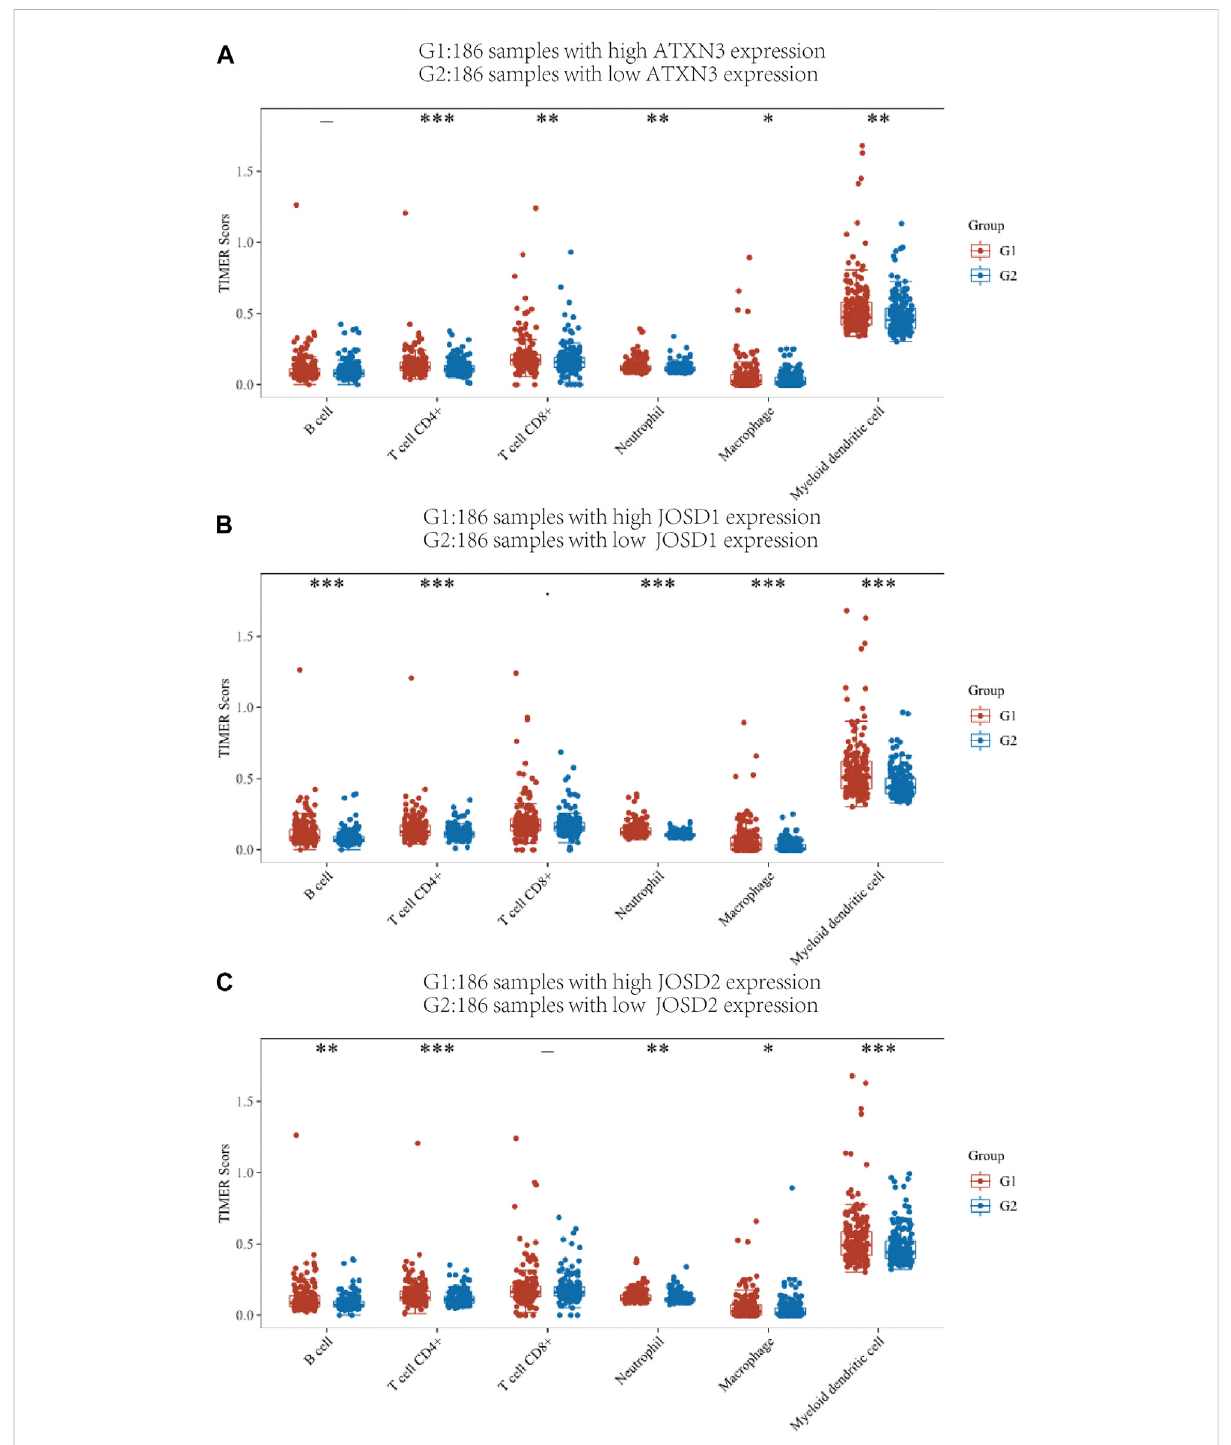
FIGURE 9 TIMER immune score of high expression group and low expression group of MJDs gene (A-C) Different colors represent different immune cell types, the abscissa represents the group, and the ordinate represents the percentage of immune cells in a single group. This graph compares the percentageabundanceoftumor-in fi ltratingimmunecellsinthehighexpressiongroup(G1)andlowexpressiongroup(G2)ofMJDsgenes.* p < 0.05, ** p < 0.01, and *** p <